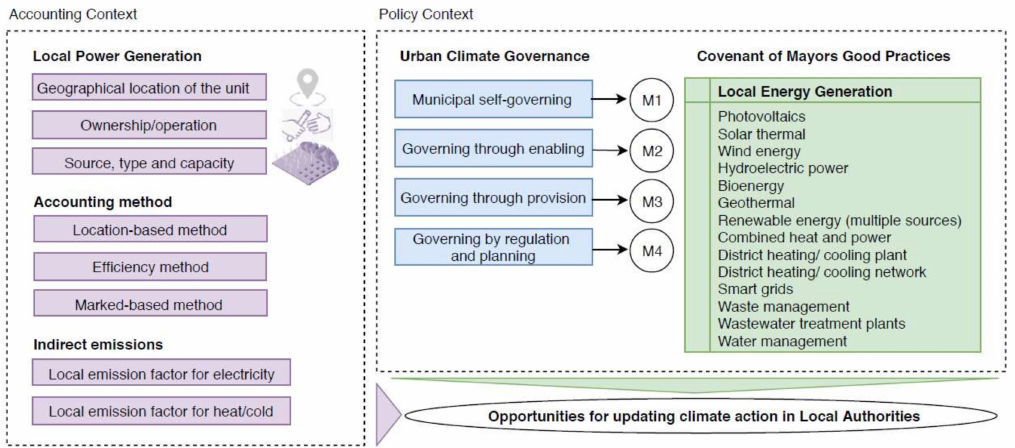
Figure 1. Overview of the accounting context and the policy context for local energy generation. Source: own